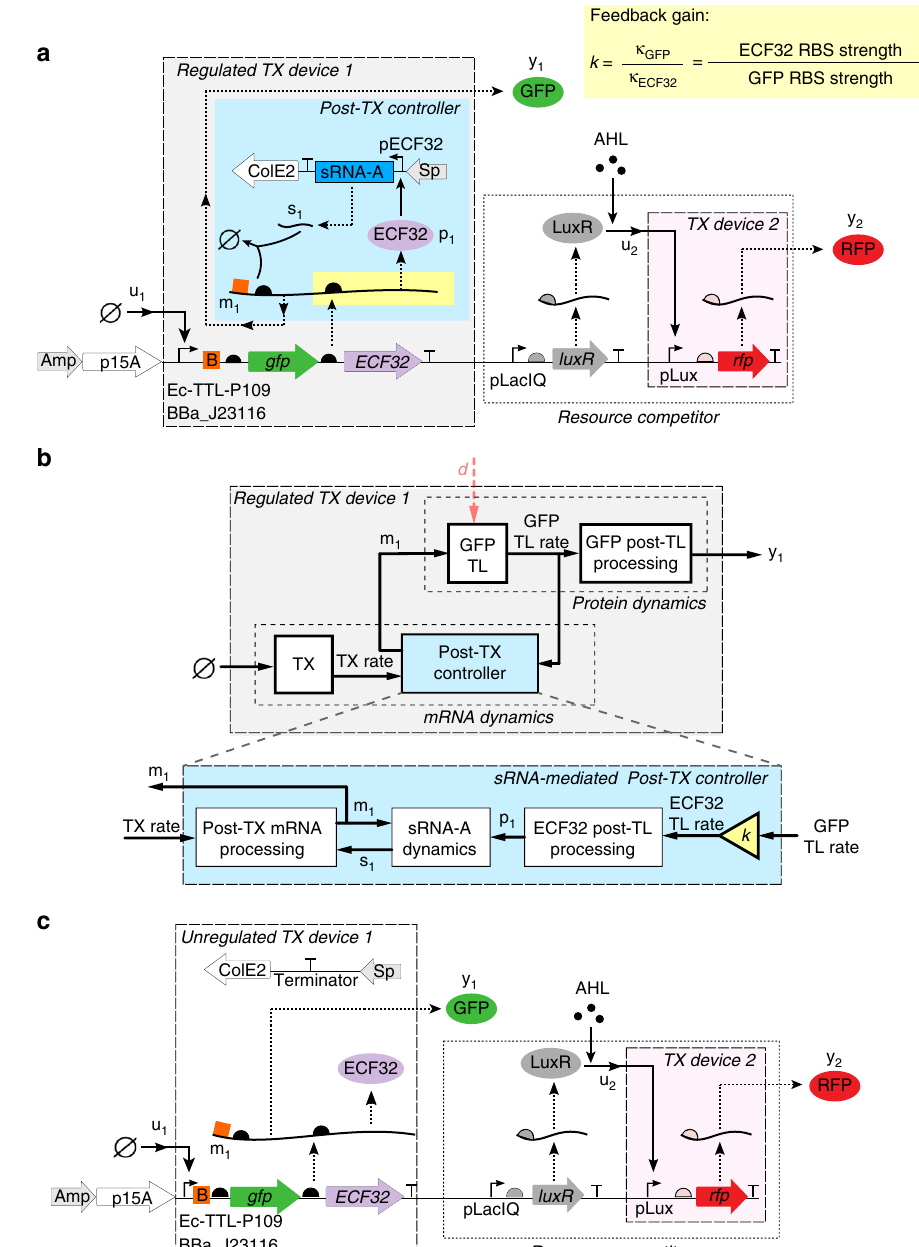
Fig. 2 sRNA-mediated post-TX controllers. a Circuit diagram of a regulated TX device 1 with inducible TX device 2 functioning as a resource competitor. Upwards arrow with tip rightwards indicate promoters, semicircles represent RBSs, orange box with letter B stands for sRNA-A targeting sequence, and “ T ” symbols represent terminators. The feedback controller consists of ECF32, co-transcribed with GFP, which is used to sense GFP translation rate and to actuate transcription of sRNA-A. sRNA-A antisenses its targeting sequence on the mRNA for degradation of both RNA molecules. b Block diagram representation of the sRNA-mediated post-TX controller. The ratio between ECF32 and GFP TL rates is k as de fi ned in panel a (see Supplementary Eq. (9) and Supplementary Note 7 for derivation), which we call here the feedback gain. ECF32 TL rate enters the ECF32 post-TL processing block, which produces ECF32 protein ( p 1 ) as output. This, in turn, enters as an input the process that produces sRNA-A s 1 (sRNA-A dynamics), which is constituted by sRNA-A TX through pECF32 and sRNA degradation (mRNA coupled and uncoupled). As a last step, sRNA-A enters the mRNA m 1 post-TX processing block to silence mRNA m 1 . c Circuit diagram of an unregulated TX device 1 with inducible TX device 2 functioning as a resource competitor. The pECF32